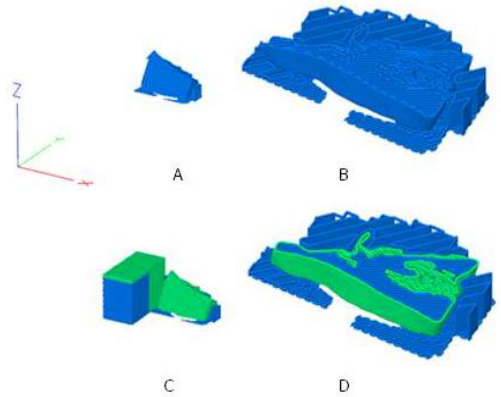
Figure 2. The sliced and orientated maxillofacial implant A [7]; ( A ): standard implant; ( B ): standard implant cut at Z = 5 mm and enlarged; ( C ): performance implant with TPU shell (green) and PETG core (blue); ( D ): performance implant cut at Z = 5 mm and enlarged; additionally shown in 3: the prime tower to the left of the implant.